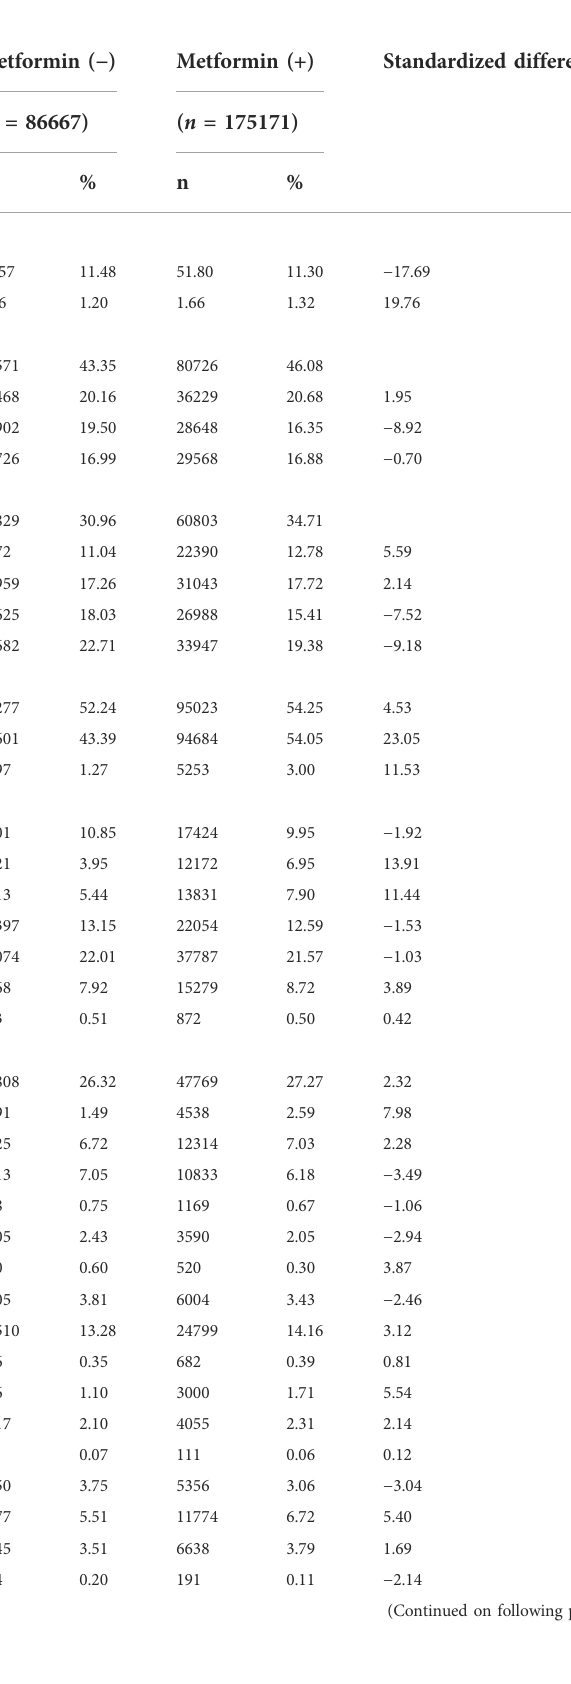
TABLE 1 Characteristics in non-metformin initiators and metformin